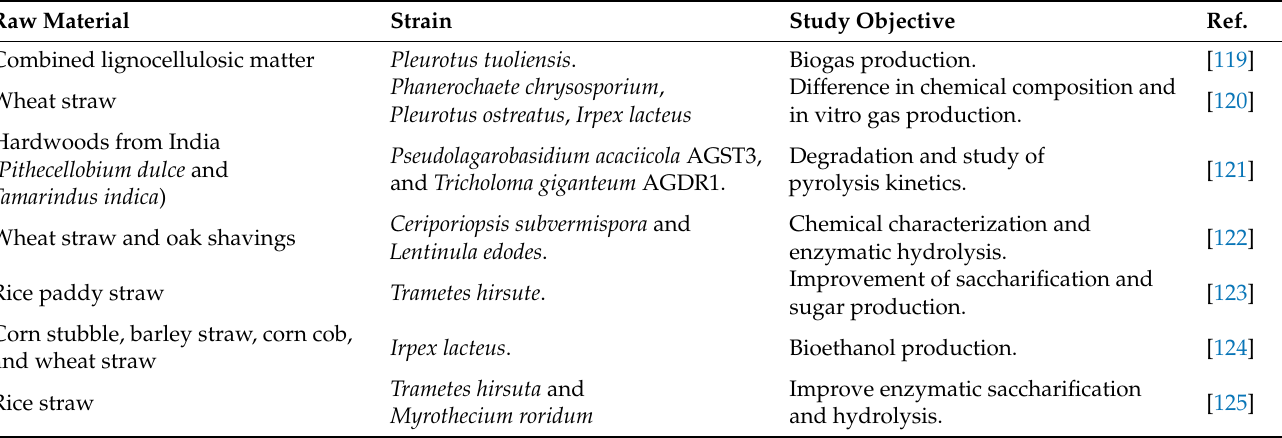
Table 4. Biological pretreatments used on different